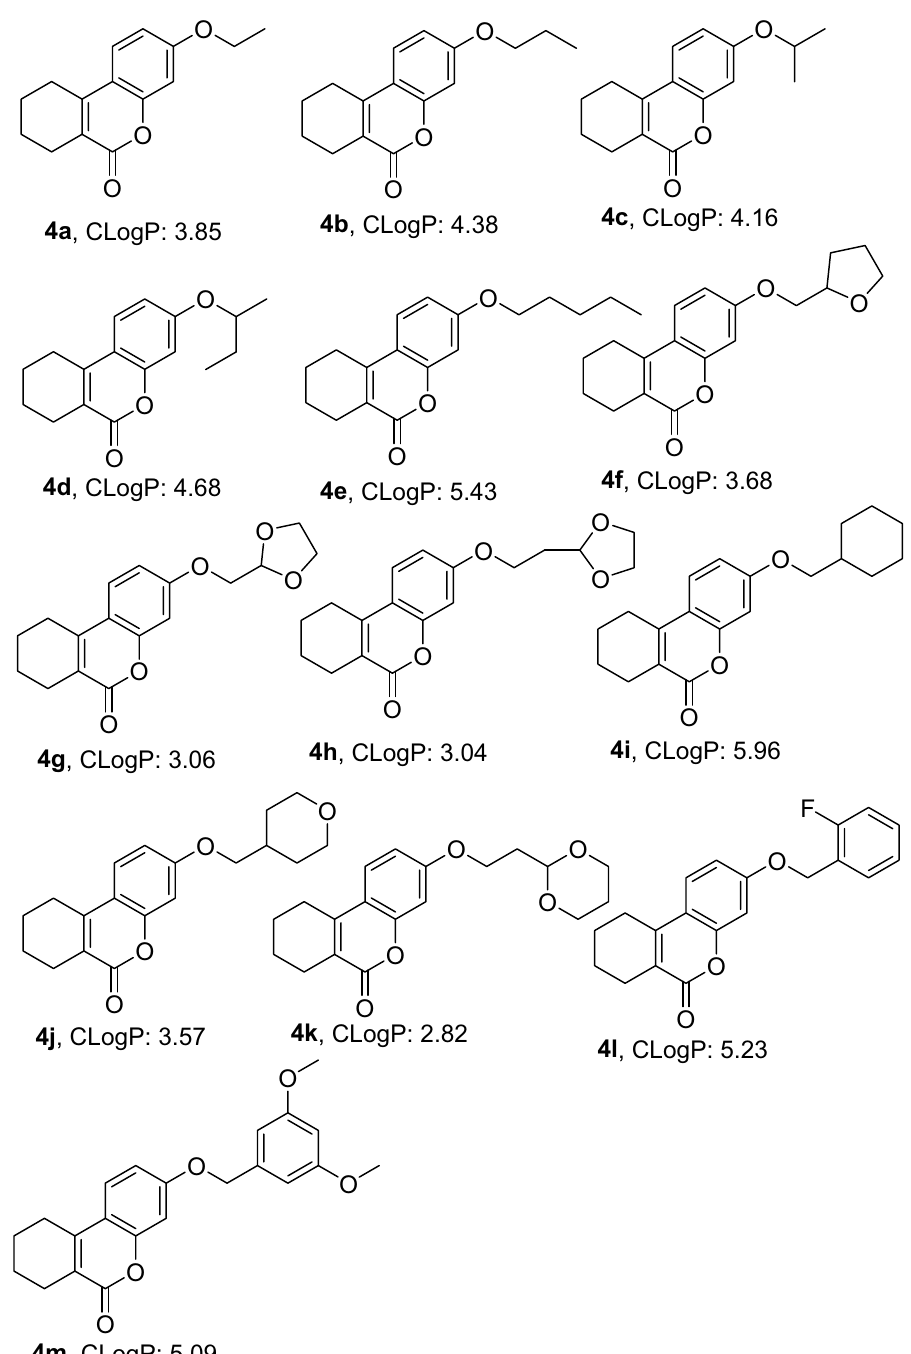
Figure 3. CLoP values of 3-hydroxy-7,8,9,10-tetrahydro-6 H -benzo[C]chromen-6-one derivatives